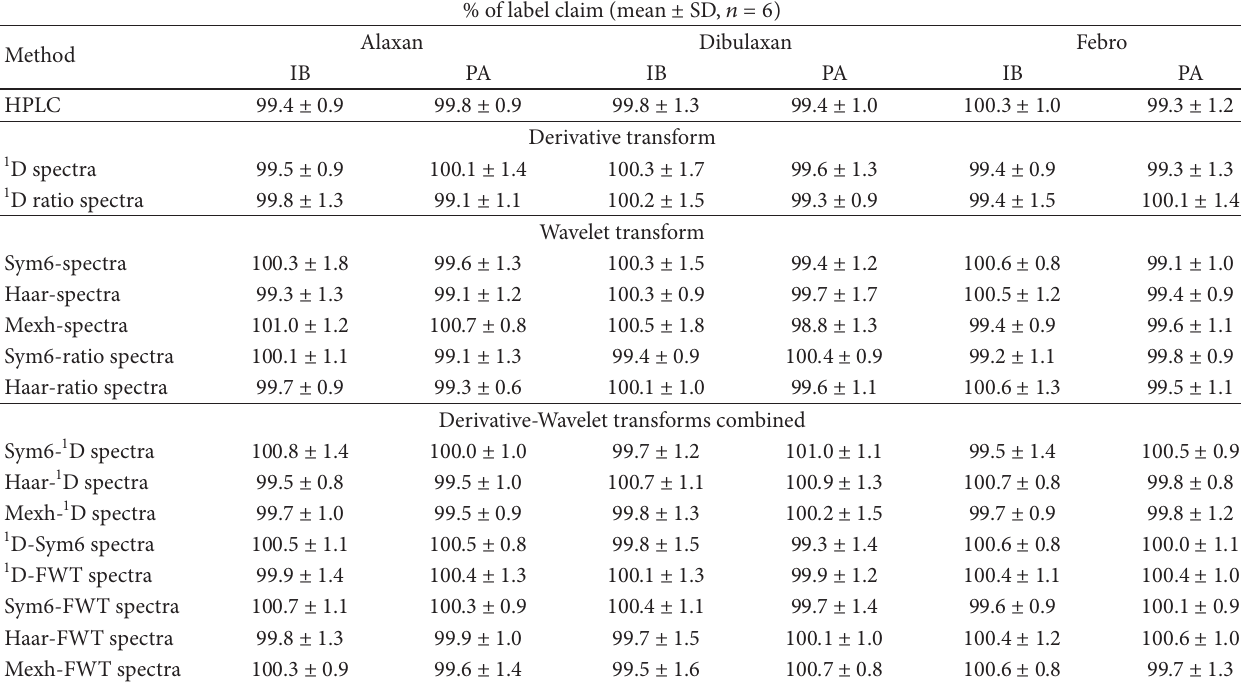
Table 2: Assay results for the determination of IB and PA in their combined tablets. % of label claim (mean ± SD, 𝑛 = 6